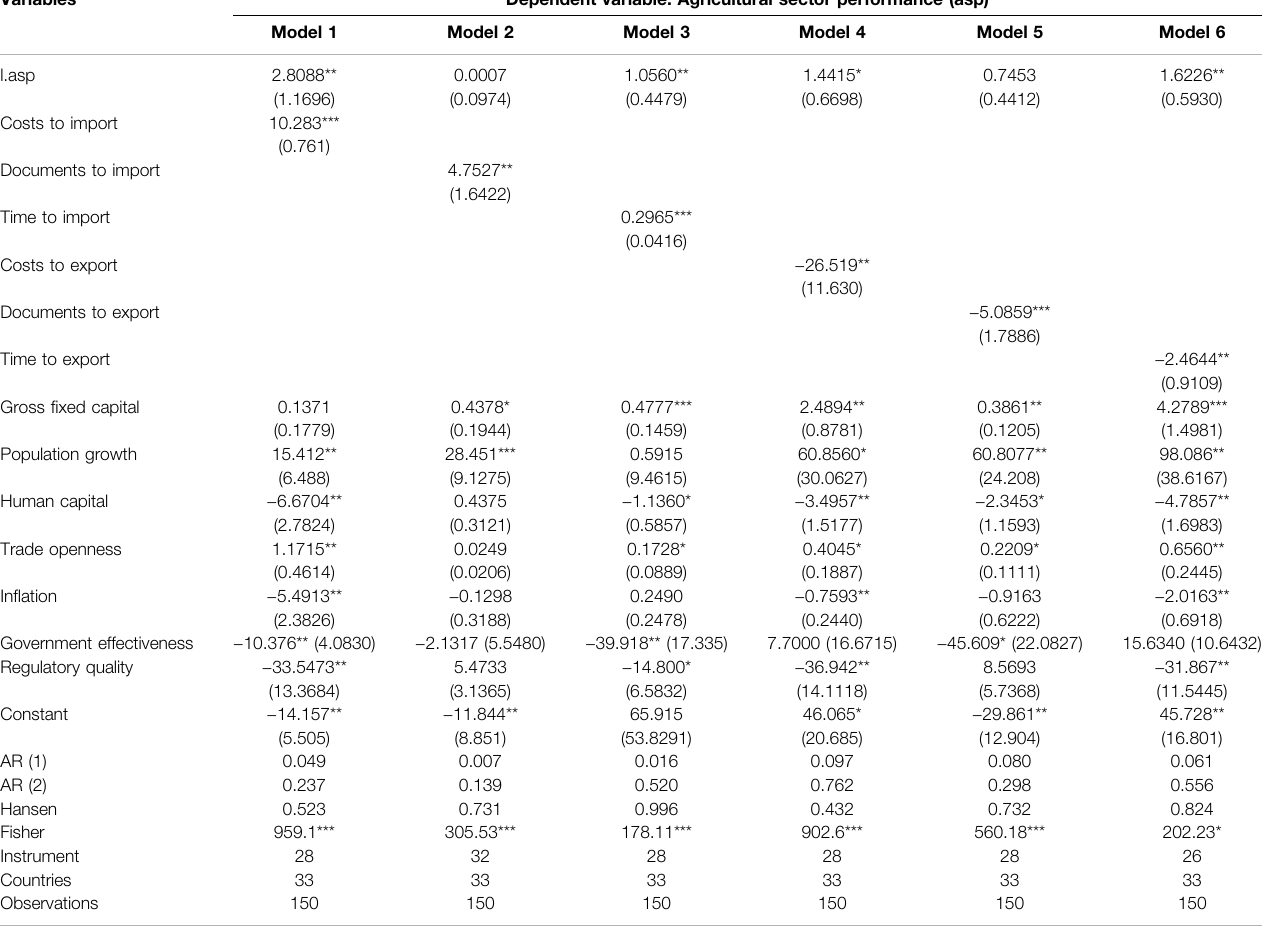
TABLE 5 | System GMM: Trade facilitation and agriculture sector